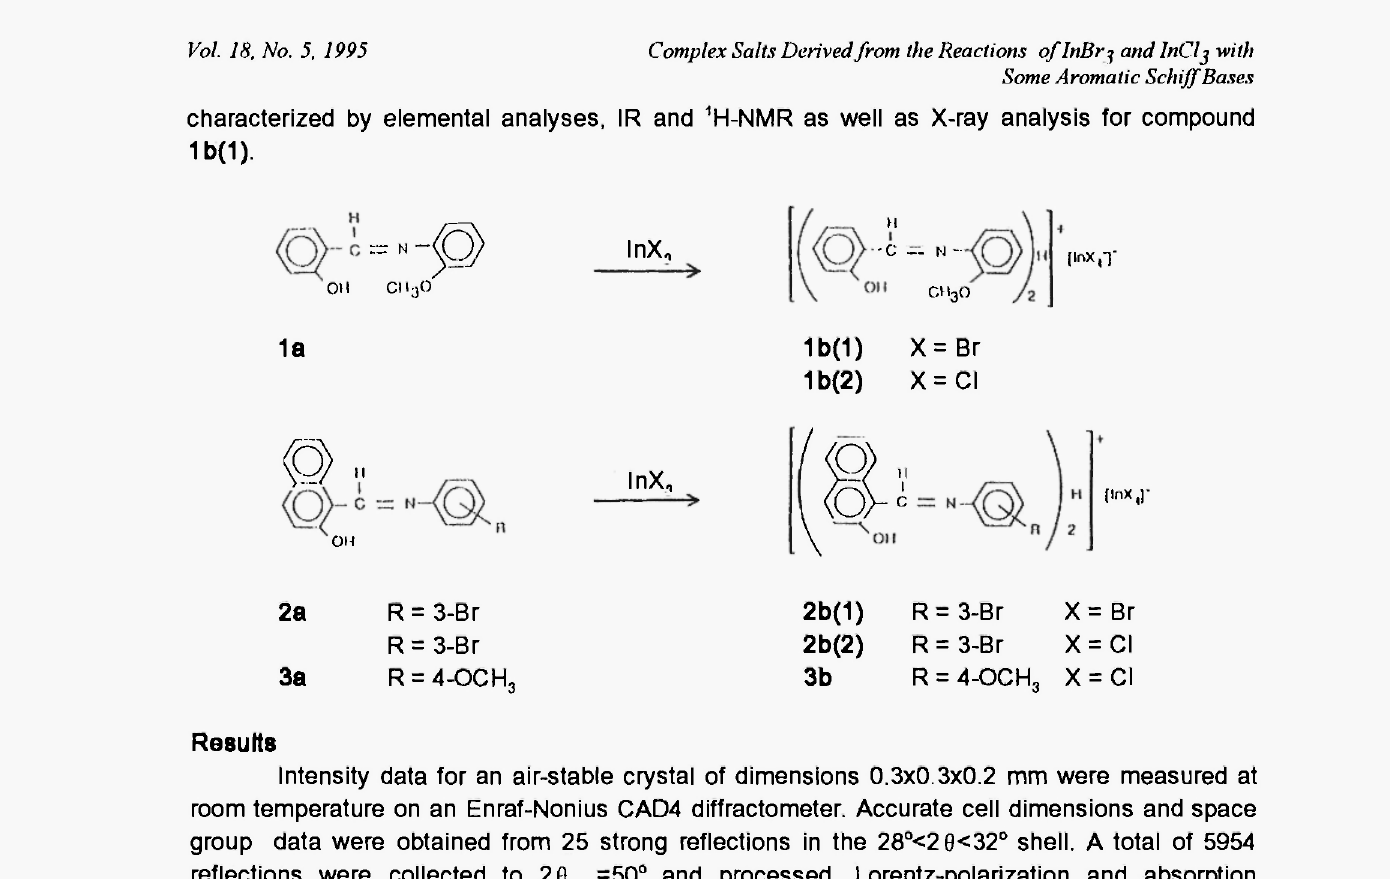
experimental section: Table 1. Atomic coordinates are given in Table 2 and the molecular structure with atom labelling is shown in Figure